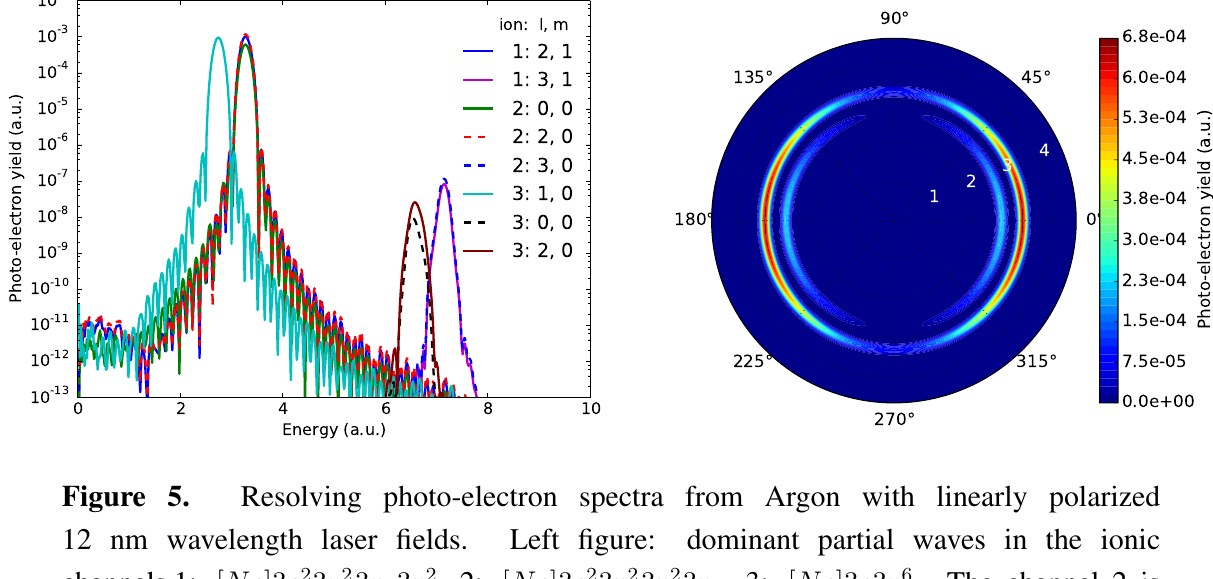
Figure 5. Resolving photo-electron spectra from Argon with linearly polarized 12 nm wavelength laser fields. Left figure: dominant partial waves in the ionic 3 p 3 p 2 3 p 2 3 p channels 1: [ Ne ]3 s 2 3 p 2 , 2: [ Ne ]3 s 2 3 p 2 , 3: [ Ne ]3 s 3 p 6 . The channel 2 is y z x z x y dominated by the s-d superposition. Right figure: Angle resolved spectra corresponding to the one-photon ionization double peak in Figure 4. The angle is defined with respect to the laser polarization